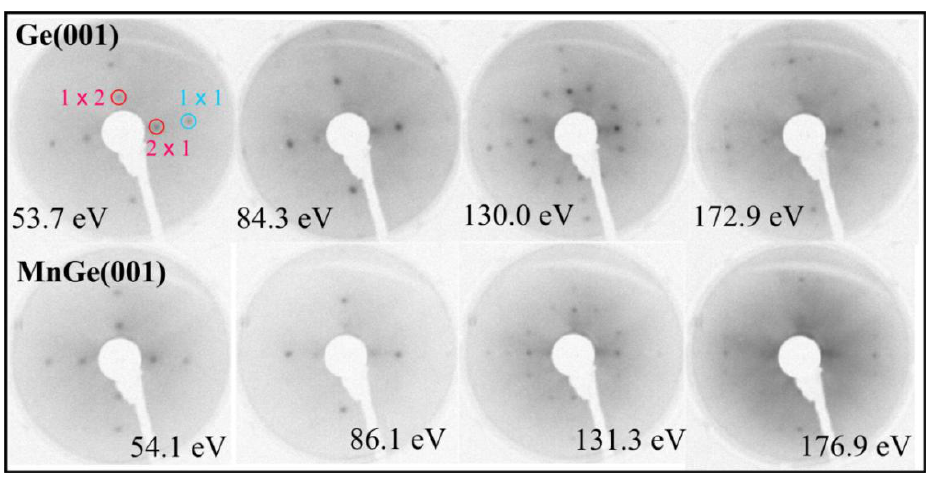
Figure 1. Low energy electron difraction (LEED) patterns for Ge(001) on the panels above, and for Mn deposited on Ge(001) at 350 °C (panels below). Each image is indexed with the energy of incoming electrons. For better clarity, negative images of the true LEED photographs are displayed. The (1 × 1), (2 × 1) and (1 × 2) spots are highlighted on one LEED image for clean Ge(001).